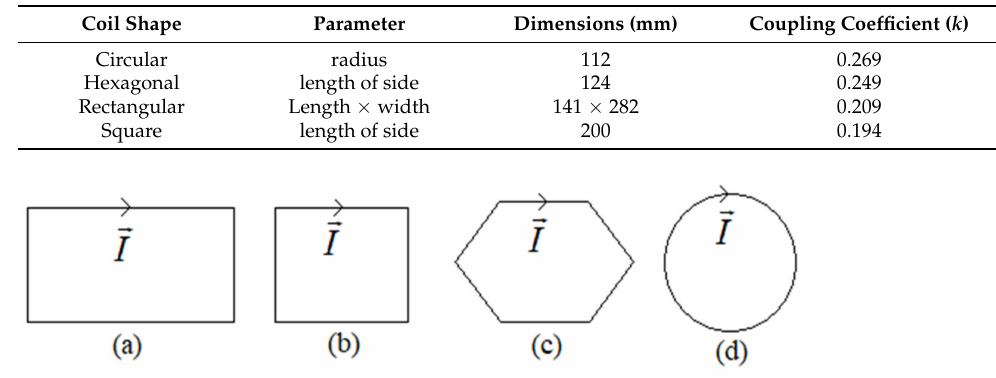
Figure 7. Coil shapes: ( a ) rectangular, ( b ) square, ( c ) hexagonal and ( d )